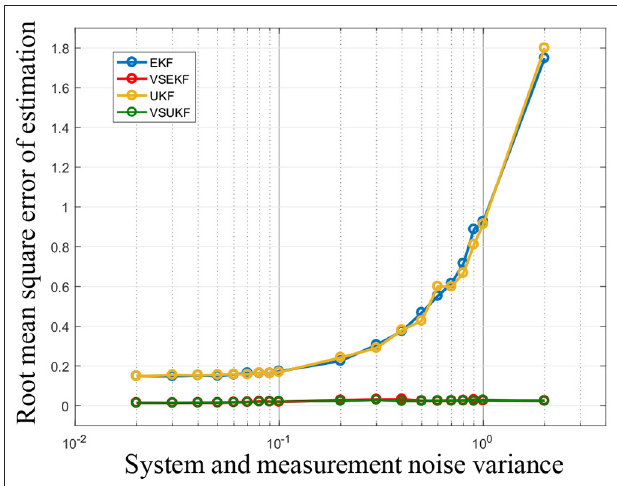
FIGURE 6 | Root mean square error (RMSE) of EKF/UKF and VSEKF/VSUKF considering different level of system and measurement